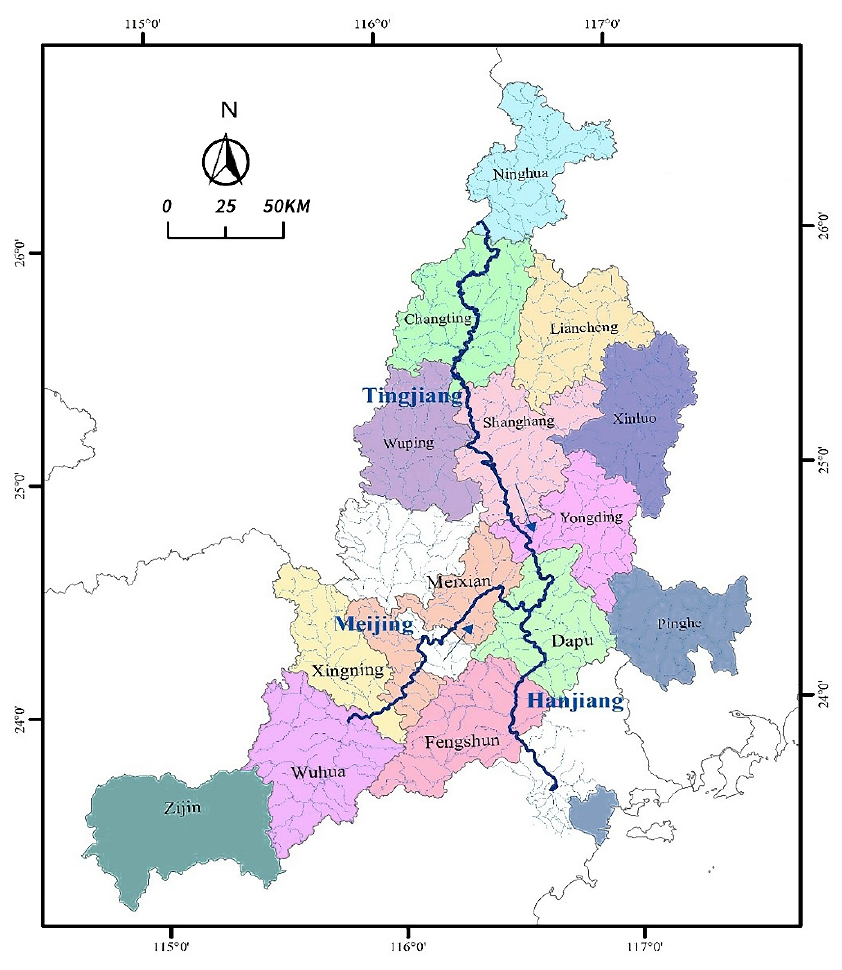
Figure 1. The natural situation of the Tingjiang River basin.